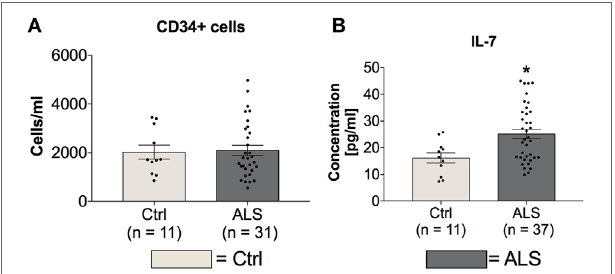
FigUre 4 | Blood concentrations of CD34 + cells and serum concentrations IL­7. Sera of Amyotrophic lateral sclerosis (ALS) patients displayed unchanged levels of CD34 + positive hematopoietic stem cells (a) and cell differentiation stimulating factor IL­7 (b) . * p < 0.05 vs. controls (Ctrl). Numbers of patients are given in brackets; all parameters were tested for Gaussian distribution using D’Augostino­Pearson omnibus normality test. Two­tailed unpaired Student’s t ­test for CD34 + cells and IL­7, data represent mean ± SEM.